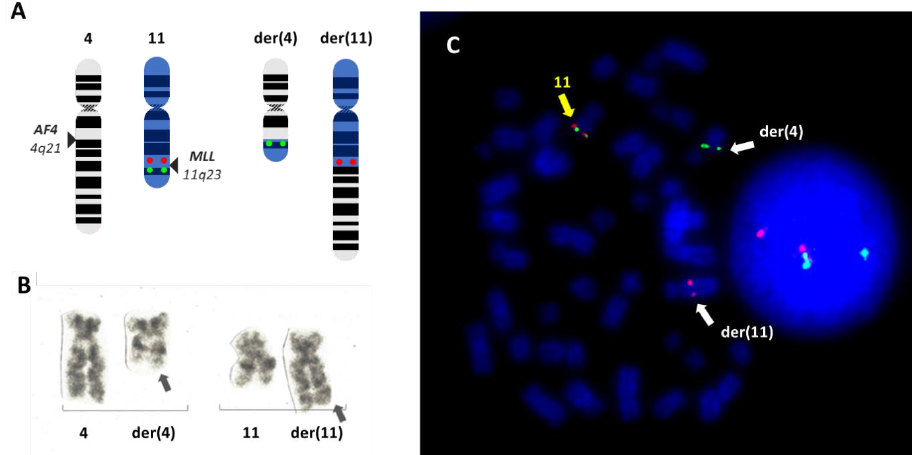
Figure 2. The t(4;11)(q21;q23) rearrangement involving MLL . Schematic representation of the translocation between chromosomes 4 and 11 giving rise to the two derivative chromosomes der(4) and der(11) ( A ). The location of the fluorescence in situ hybridization (FISH) probe XL MLL (Metasystems) is also indicated on the normal chromosome 11, consisting of one green and one red signal flanking the MLL locus at 11q23. In the event of the translocation, the two signals split, indicating the disruption of the MLL locus. As a result, the der(11) retains the red signal proximal to MLL , while the der(4) will contain the green signal corresponding to the distal portion of MLL . These patterns are visible in a representative metaphase from the RS4;11 cell line, known to harbor a t(4;11)(q23;q21), hybridized with the XL MLL probe ( B ). The same rearrangement is shown in ( C ), obtained by G-banding.